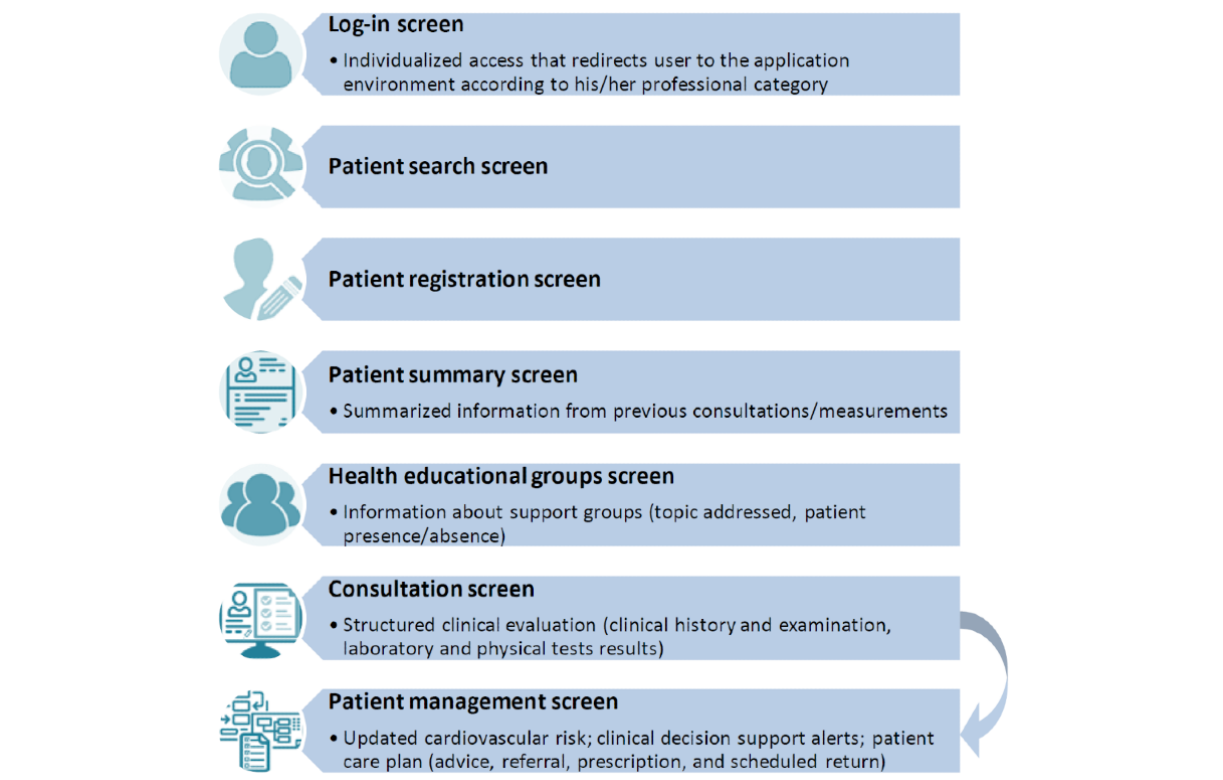
Figure 2. The main functionalities of the